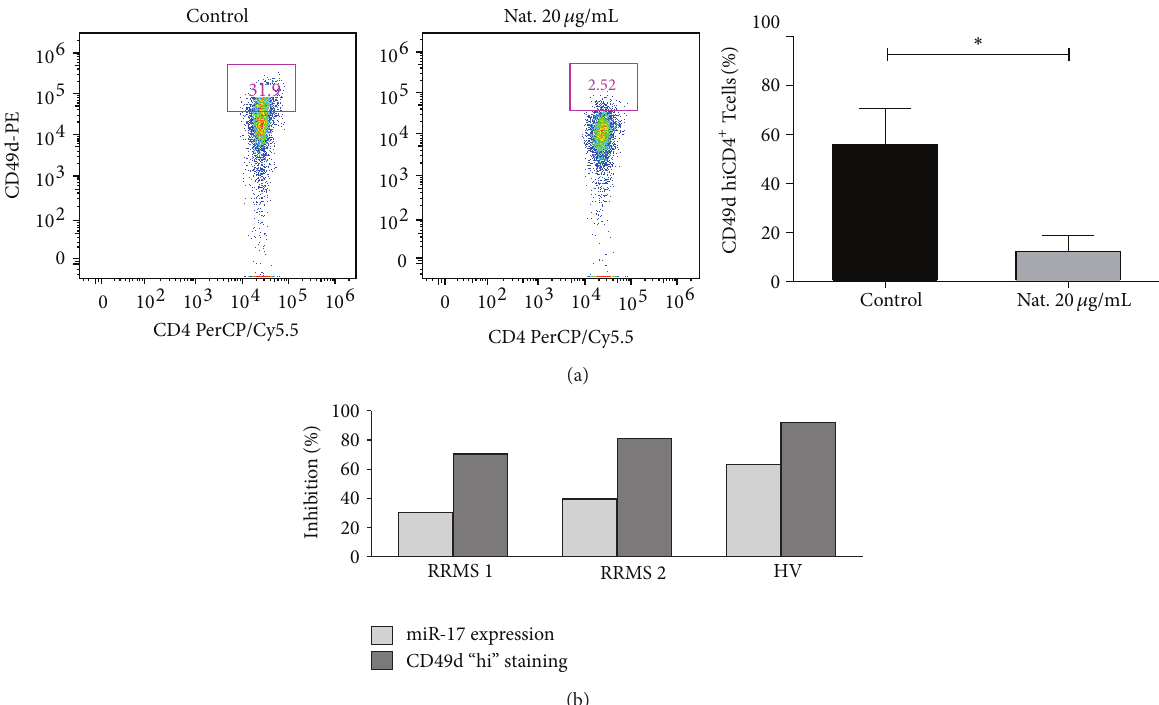
Figure 2: Natalizumab effect ex vivo . Isolated CD4 + T cells from untreated (control) or natalizumab treated PBMCs were stained for CD49d expression and processed for miR-17 expression quantification (RRMS, 𝑛 = 2 ; HV, 𝑛 = 1 ). (a) (Left panel) Representative FACS dot plots of CD4 and CD49d surface expression in cells from a HV. (Right panel) Percentage of CD49d hi cells among CD4 + T cell populations. Bars represent mean with SEM (standard error of the mean) in three independent experiments; (RRMS, 𝑛 = 2 ; HV, 𝑛 = 1 ). (b) Percentage of inhibition of miR-17 expression and CD49d hi staining in natalizumab treated cells. Paired 𝑡 -test was applied. ∗ 𝑃 < 0.05 .